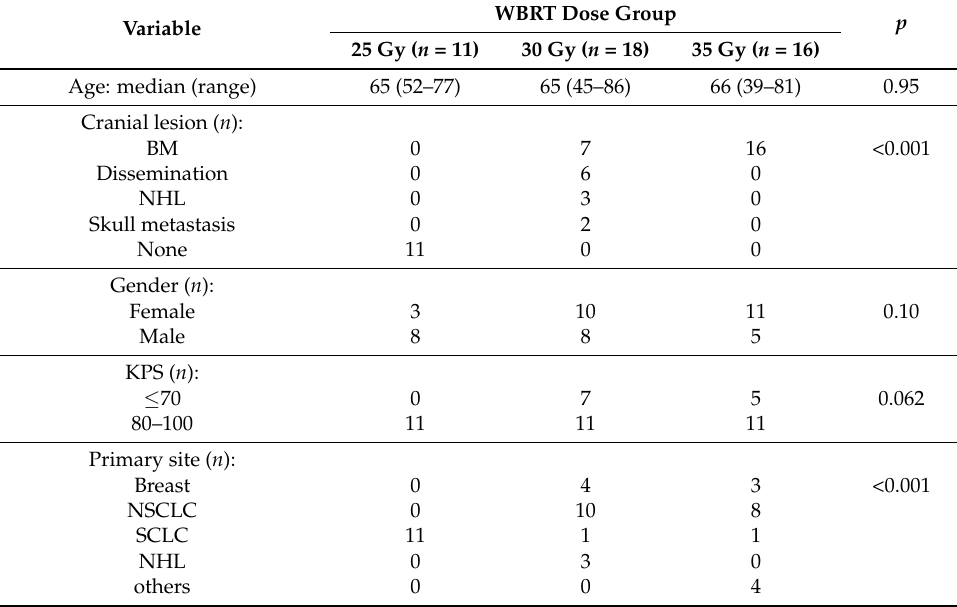
Table 1. Patient characteristics of each WBRT dose